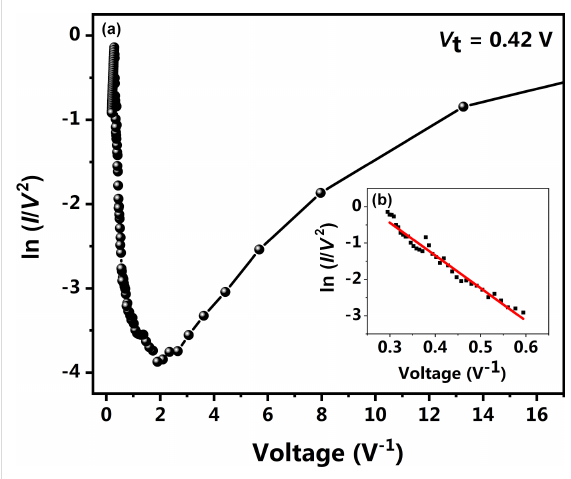
Figure 7: (a) Plot of ln( I / V 2 ) as a function of V − 1 for PbPc on single- layer graphene showing a transition from direct tunneling to F-N tunneling and (b) linear fit for the region of F-N